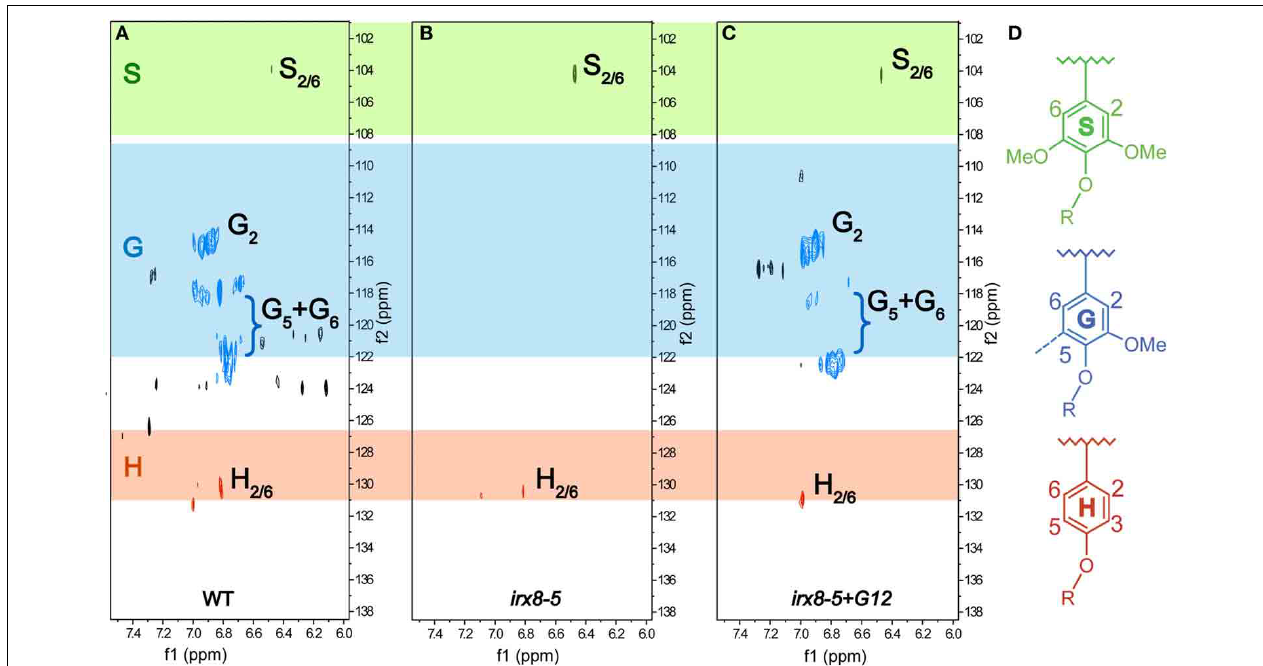
FIGURE 5 | Aromaticregionsof2D 13 C- 1 HHeteronuclearSingle-Quantum Correlation (HSQC) NMR spectra. Chlorite extracts prepared from WT (A) , irx8-5 (B) , and irx8-5 + GAUT12 (C) stem alcohol insoluble residues (AIR) are